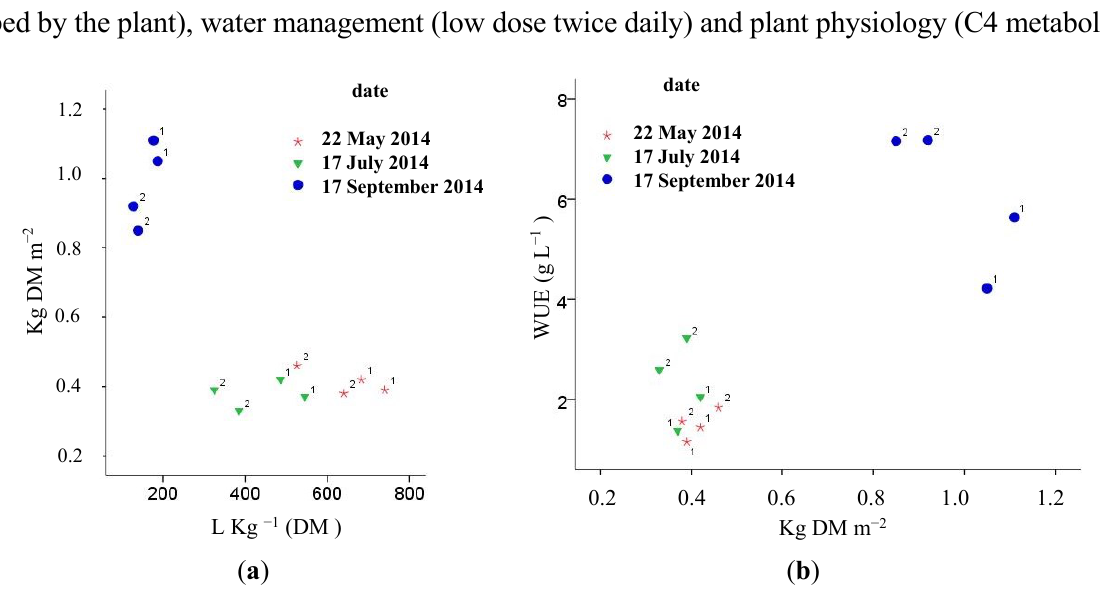
Figure 4. ( a ) Yield (kg·m −2 DM) and water consumption coefficient (L·kg −1 MS) for both treatments (100% and 60% of the dose) and∙harvest; and ( b ) relationship between water use efficiency (WUE, in g·L −1 ) and crop yield (kg·m −2 DM) obtained for the∙harvests and treatments (1 and